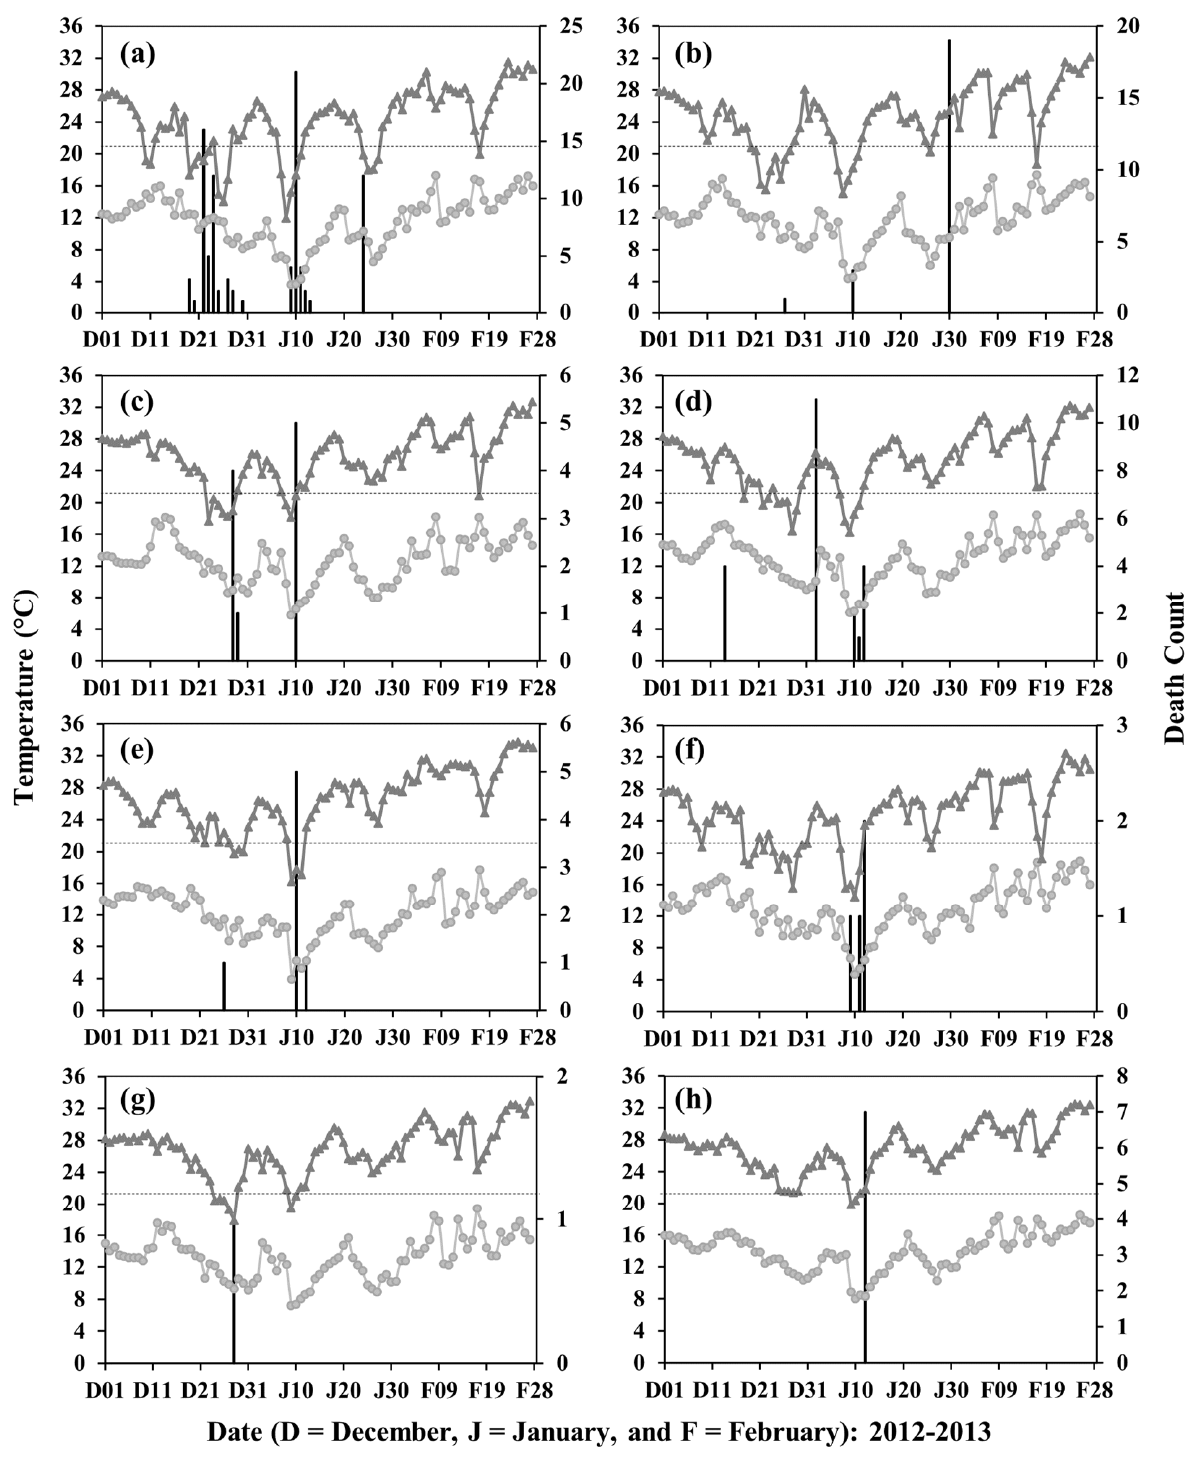
Figure 6. Relationship between cold-related deaths and winter temperatures for 2012 ‒ 2013 in the divisions of ( a ) Rangpur, ( b ) Rajshahi, ( c ) Khulna, ( d ) Dhaka, ( e ) Sylhet, ( f ) Mymensingh, ( g ) Barishal, and ( h ) Chattogram. Horizontal dotted lines represent moderate cold at 21 °C.